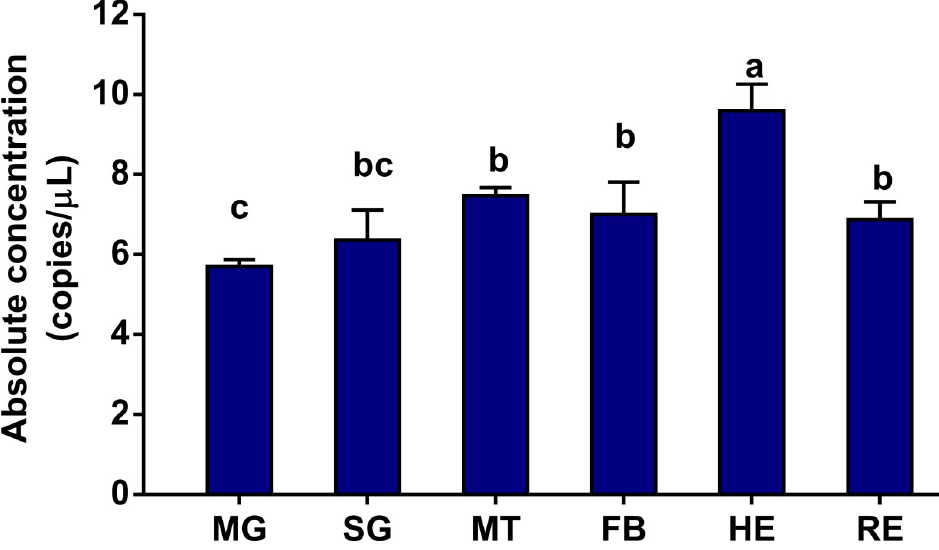
Fig 7. Validation of reference gene selection using ddPCR. MG: midgut, SG: silk gland, MT: Malpighian tubule, FB: fat body, HE: hemolymph, RE: remaining tissues. The data were presented as the mean ± SD (one-way ANOVA followed by a Tukey’s multiple comparison test, p <